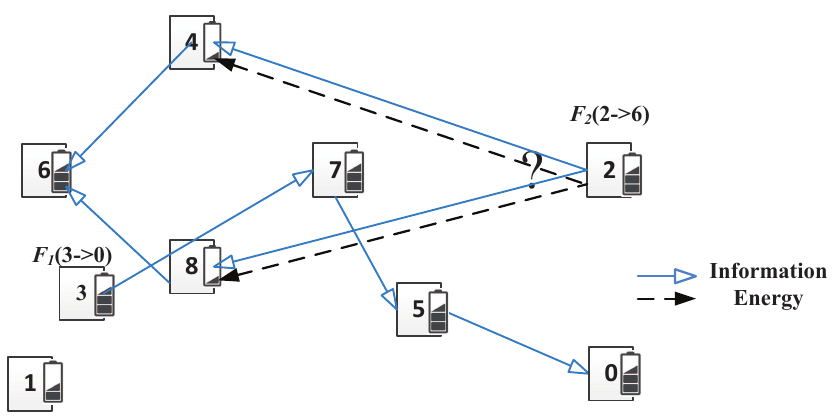
Figure 1. Network Model. There are multiple concurrent flows. There exists a flow F 1 ( 3 → 0 ) = 3 → 7 → 5 → 0. Which path is better for a new arrived flow F 2 ( 2 → 6 ) , path 2 → 4 → 6 with less interference or path 2 → 8 → 6 with more